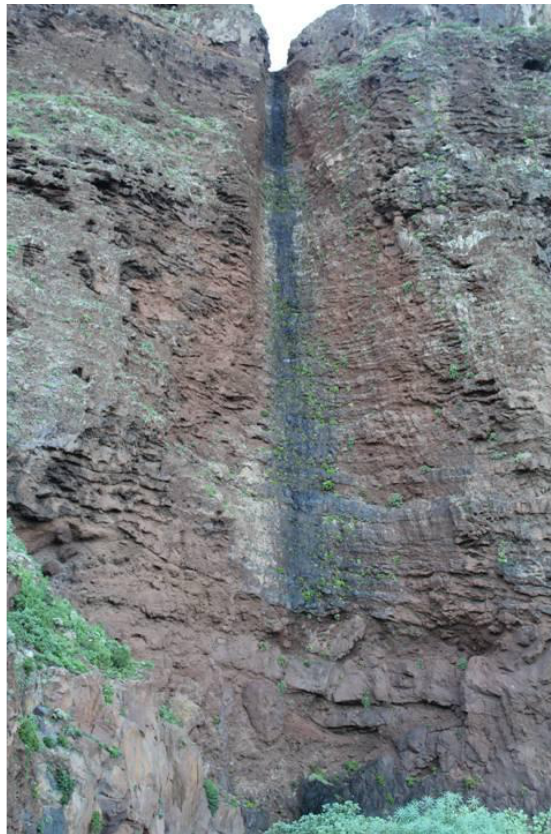
Fig. 4. Vertical cliff, about 120 m high, of thin basaltic lava flows at the peninsula of Teno in Tenerife, Canary Islands. View looking west, the cliff is composed of tens of lava flows, most of which are about one meter thick and with thin layers of scoria between the lava flows. Overall, the rocks that constitute the cliff, as well as many other sea cliffs in this old basaltic part of Tenerife, have very similar mechanical properties and the cliff functions effectively as a single mechanical layer.